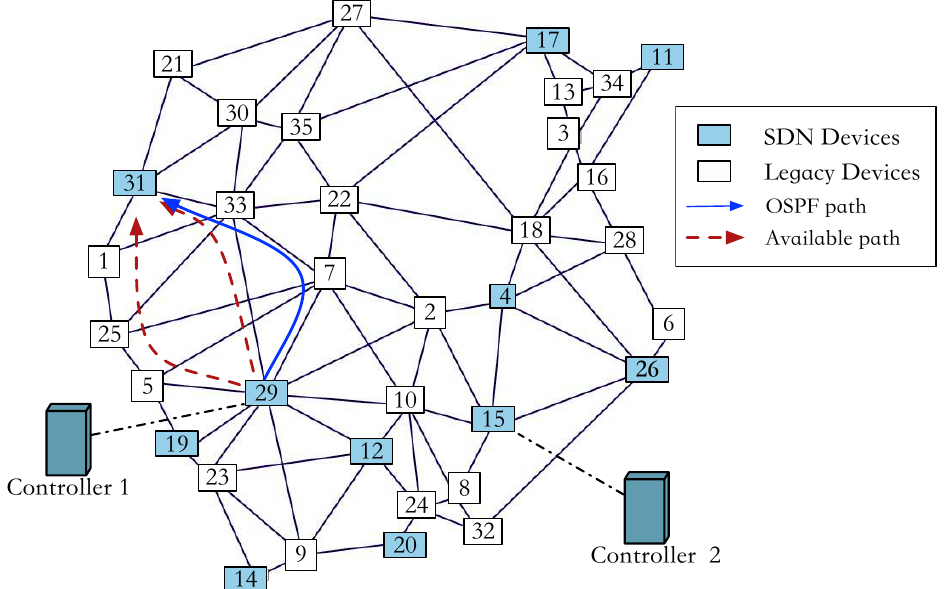
Figure 1. A hybrid SDN network with two controllers. SDN: Software-defined